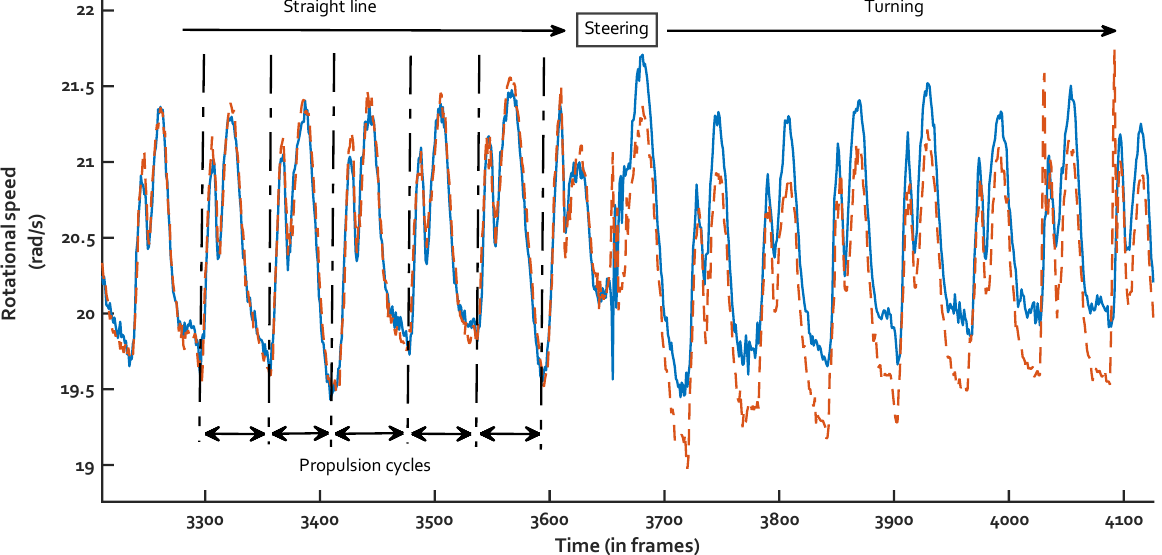
Figure 2. Cycle identification on MWC wheels rotational velocity curves. [Blue continuous line = right wheel; Orange dashed line = left wheel].